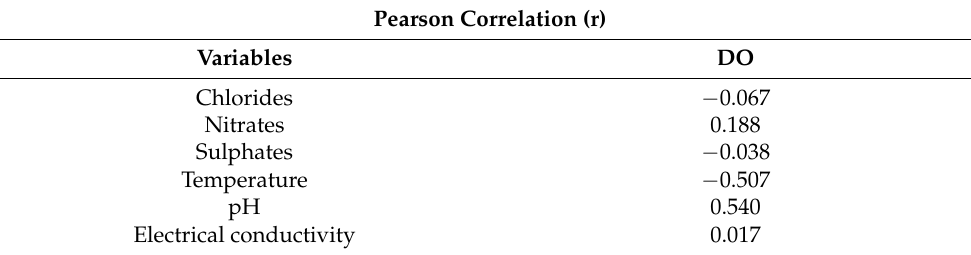
Table 2. Values obtained for the Pearson correlation coefficients between DO and different variables.